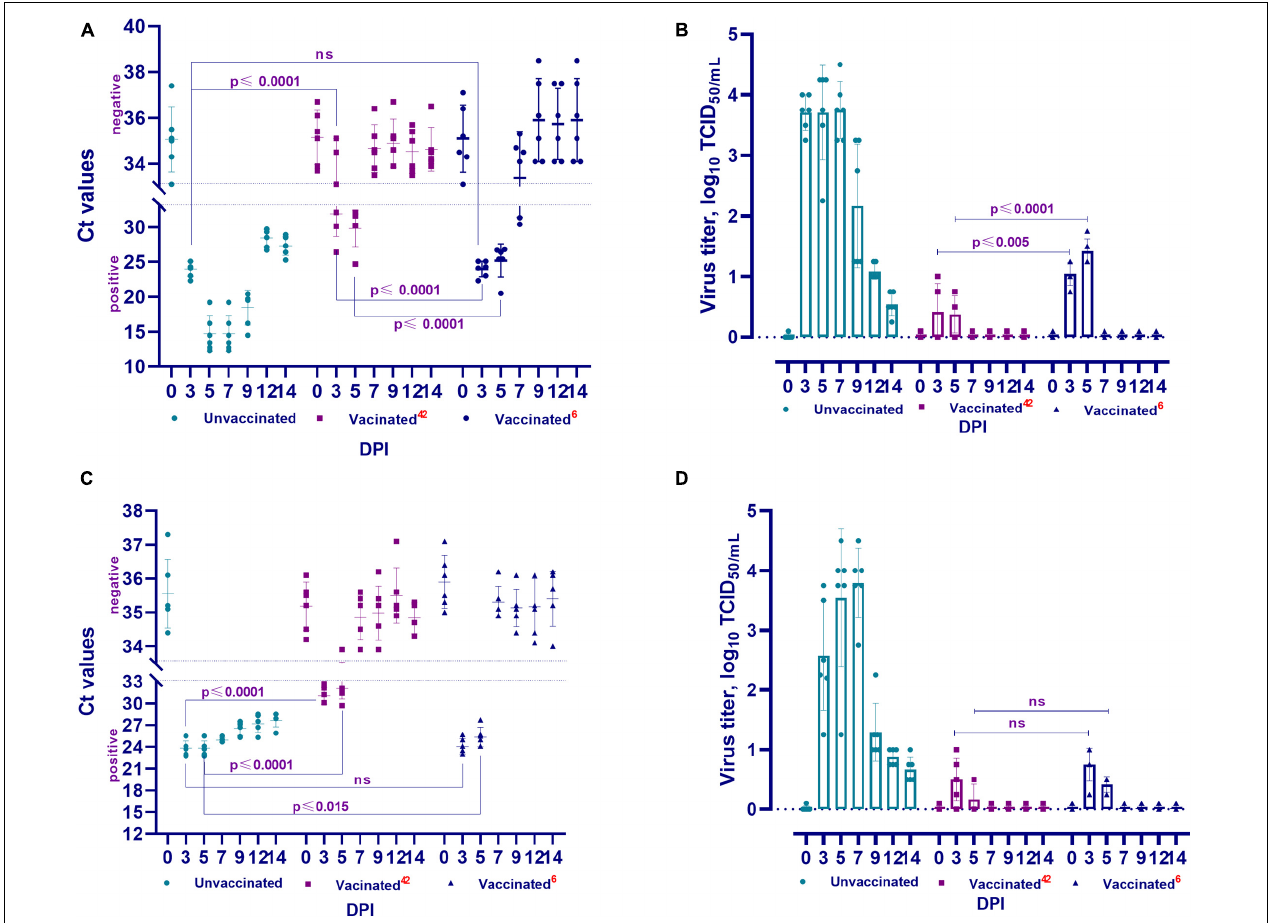
FIGURE 5 | Viral RNA load and isolation for cell culture of challenged animals. The PCR results of nasal swabs (A) and oral swabs (C) , and the virus isolated for cell culture from clinical samples from vaccinated and unvaccinated hamsters after challenge with wild homologous SARS-CoV-2 virus ( B: nasal swabs; D: oral swabs). Ct values between 10 and 33 are positive, while Ct values ≥ 33.1 are negative; 42 indicates the vaccinated group challenged at 42 days after vaccination, 6 indicates the vaccinated group challenged 6 months after vaccination. ns indicates no